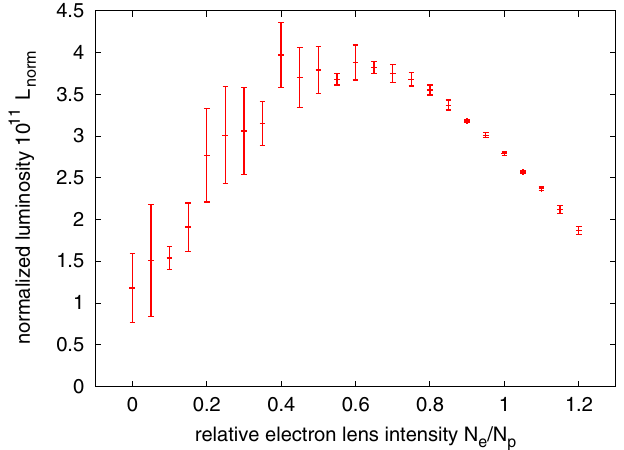
FIG. 10. (Color) Maximum normalized luminosity obtained dur- ing tune scans as a function of the relative intensity N e =N p of the electron lens. While in the undercompensated case N e =N p < 1 the maximum luminosity occurs at fractional tunes of ; Q Þ ¼ ð 0 : 04 ; 0 : 06 Þ , the highest luminosity in the overcom- ð Q x y pensated case N e =N p > 1 is reached at a working point near (0.20, 0.21).